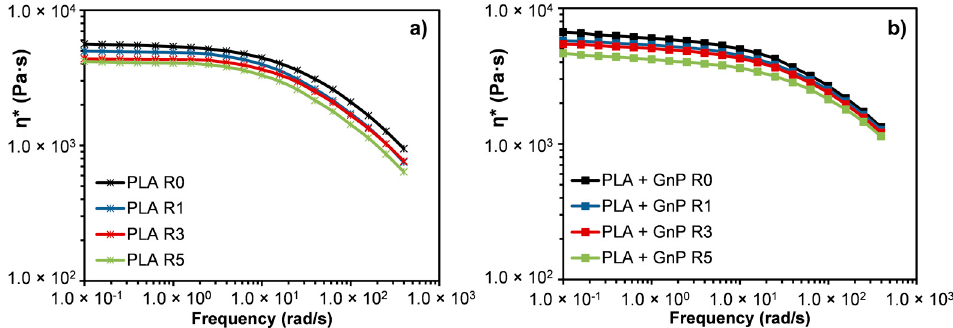
Figure 7. Complex viscosity as a function of frequency of ( a ) PLA and ( b ) PLA + GnP underwent to reprocessing.